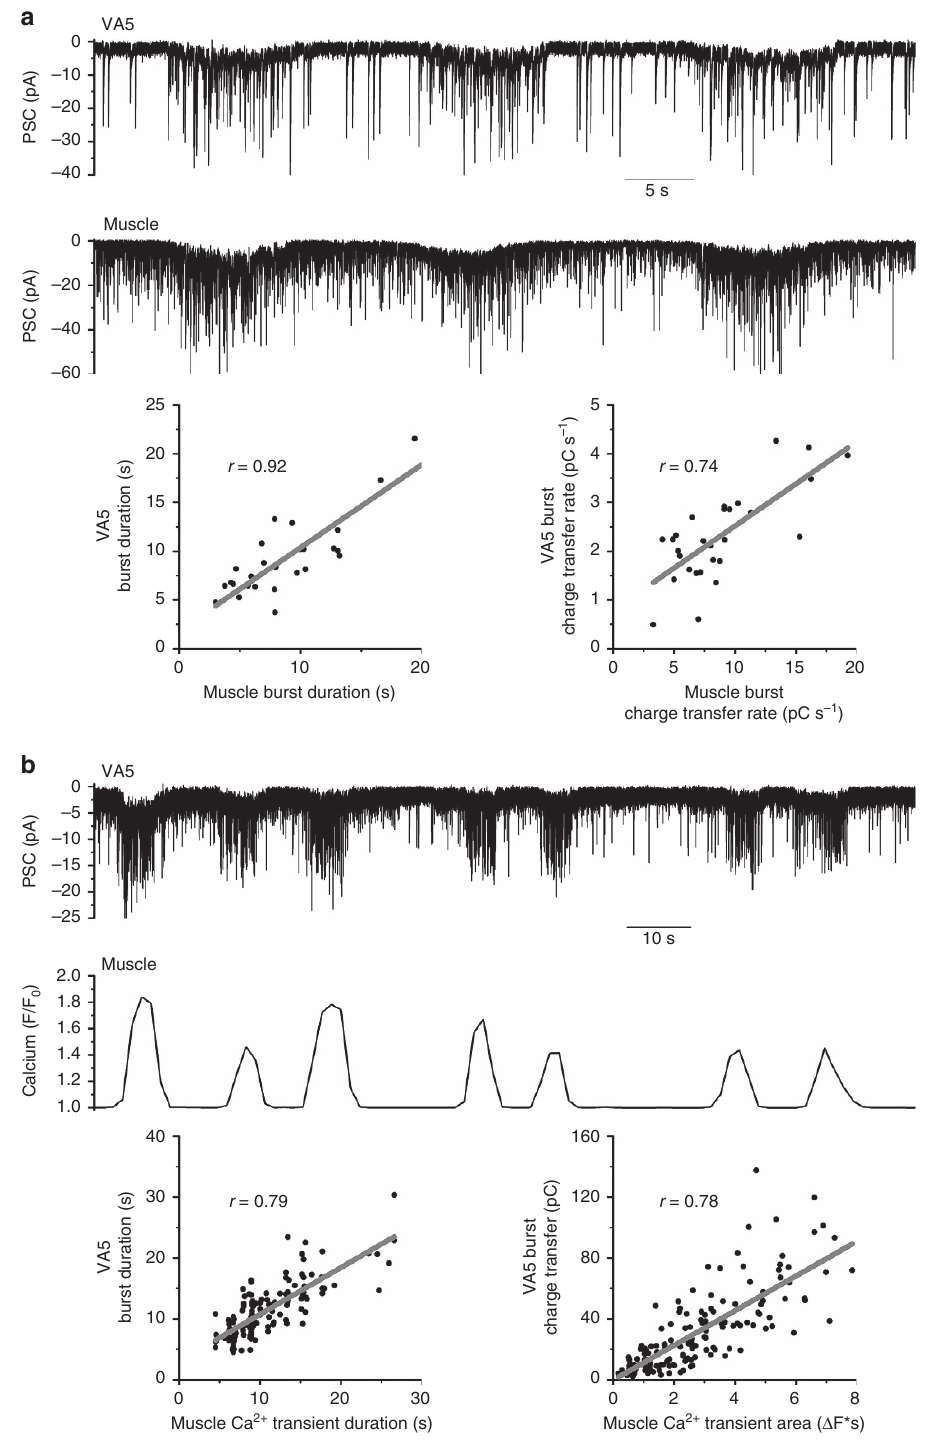
Figure 2 | Postsynaptic current (PSC) bursts in VA5 are concurrent with PSC bursts and Ca 2 þ transients in adjacent body-wall muscle cells. ( a ) Sample traces showing temporal relationship between PSC bursts recorded from VA5 and an adjacent muscle cell, and scatter plots showing correlations of duration and mean charge transfer rate between PSC bursts recorded from VA5 and muscle cells ( n ¼ 5). ( b ) Sample traces showing temporal relationship between PSC bursts recorded from VA5 and Ca 2 þ transients from an adjacent muscle cell, and scatter plots showing correlations between their durations and strengths ( n ¼ 10). In both panels, each dot in a scatter plot represents one PSC burst or Ca 2 þ